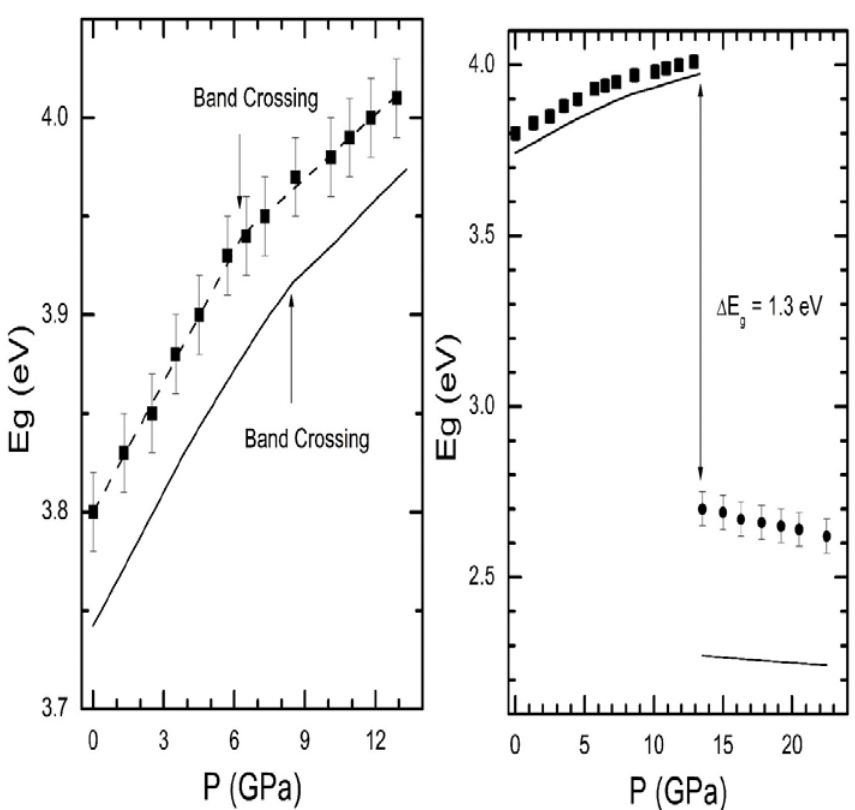
Figure 9. ( left ) Pressure dependence of E g in the low-pressure phase of InTaO 4 . The change in the pressure dependence caused by the band-crossing induced by pressure is indicated with arrows. ( right ) Pressure dependence of E g in the low- and high-pressure phases of InTaO 4 . The band-gap collapse associated with the transition is indicated (E g = 1.3 eV). In both figures, symbols correspond to experiments and lines to calculations.